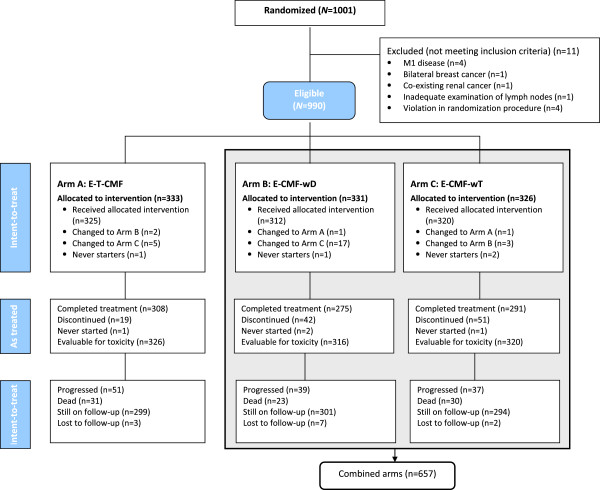
CONSORT diagram.